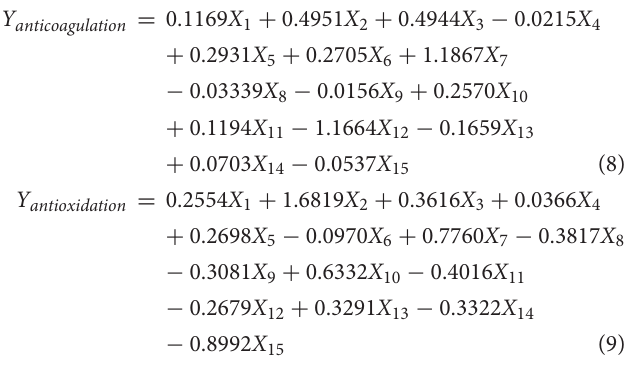
steaming time. For PN steamed for the same time, the higher the steaming temperature, the higher was the EC 50 values of